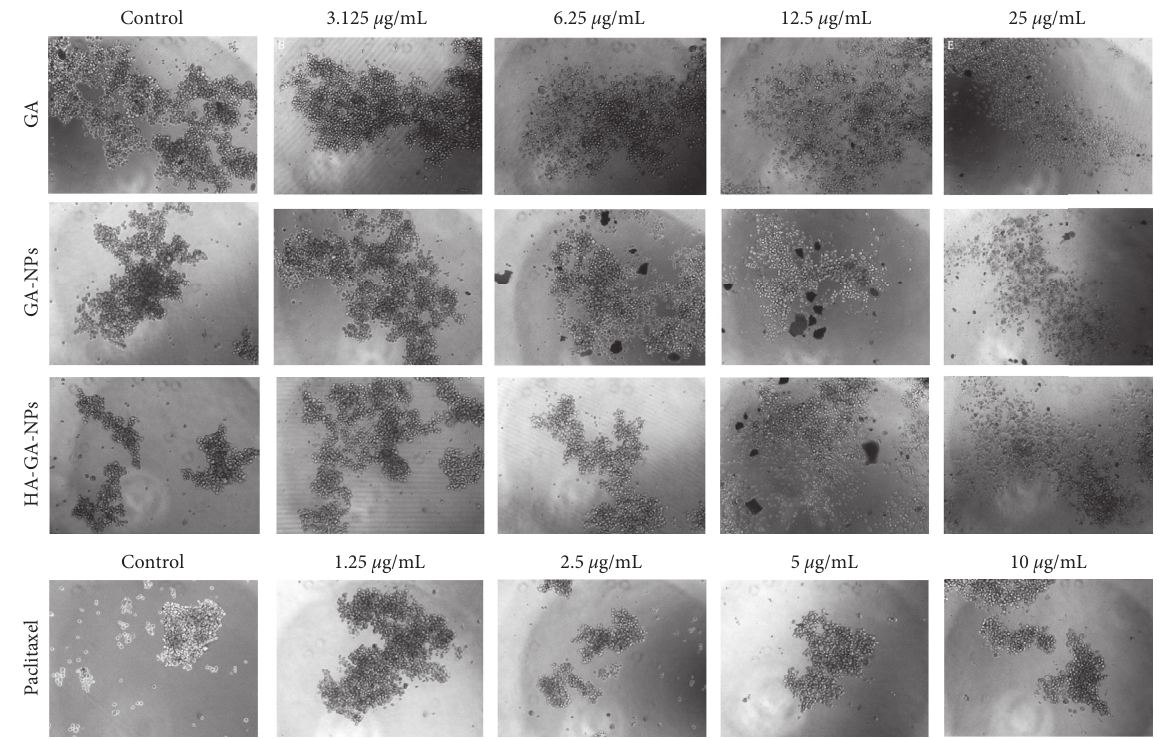
Figure 2: Morphological changes in bCSCs incubated with GA, GA-NPs, HA-GA-NPs, and paclitaxel for 24h (magnification: 100x). Table 5: IC 50 value of each NP assessed at 24, 48, and 72h incubations.